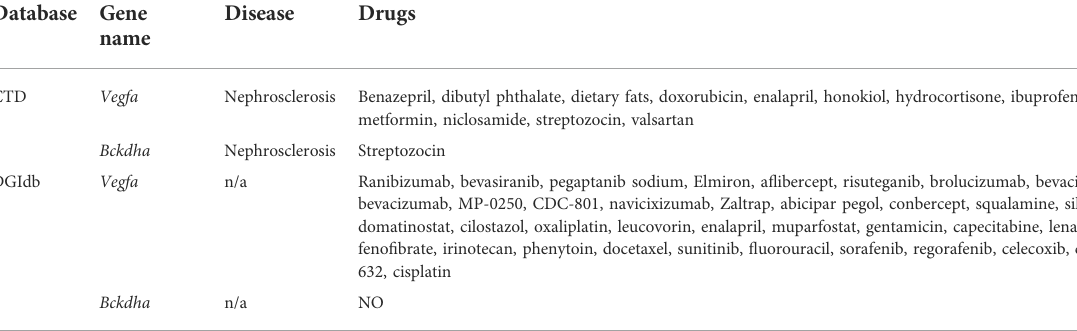
TABLE 3 Drugs that can target Vegfa and Bckdha as predicted by the CTD and